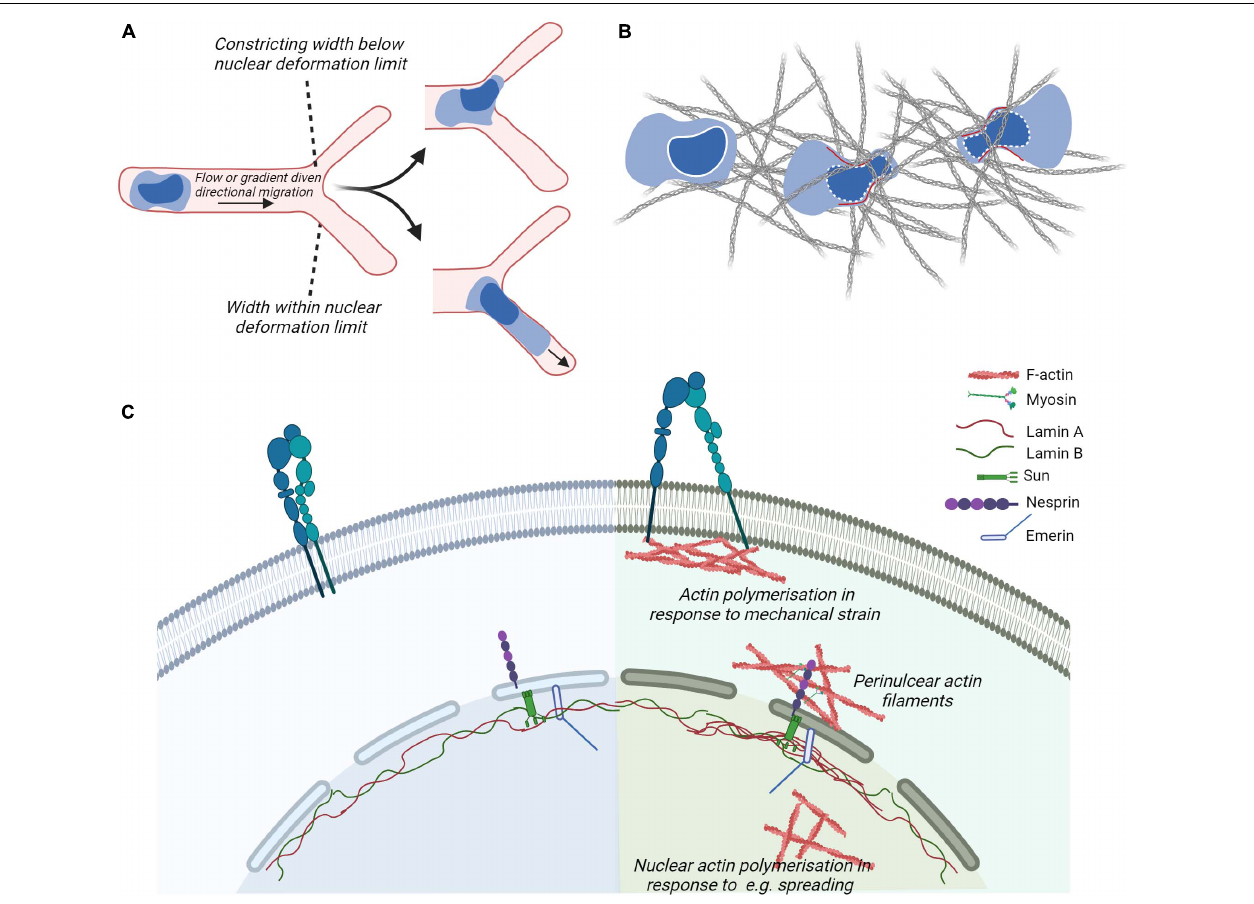
FIGURE 4 | Cytoskeletal coupling of the nucleus and cytoplasm . (A,B) In leukocytes navigating confined environment such as vessel entrances or dense matrices, the mechanical properties and responses of their nuclei play important regulatory roles such that constraints induce nuclear envelope disassembly and generation of forces (in red) to promote leukocyte escape from the compressive environment and identify paths of least resistance. (C) Actin cytoskeletal adaptations to plasma membrane proximal signaling or mechanical strain, e.g., through the generation of focal adhesions and perinuclear actin filaments couple to the nuclear cytoskeleton through the nuclear envelop. The outer nuclear envelop proteins such as Nesprin confer recognition of cytoplasmic cytoskeletal proteins such as actin or microtubules (not shown). Inner envelop proteins such as Sun and Emerin enable the connection of Nesprin family of proteins to the intermediate filaments making up the nuclear lamina. The nuclear lamina contribute to the mechanical properties of cell and adapt to mechanical stimulation, e.g., by displaying localized accumulation in response to strain.